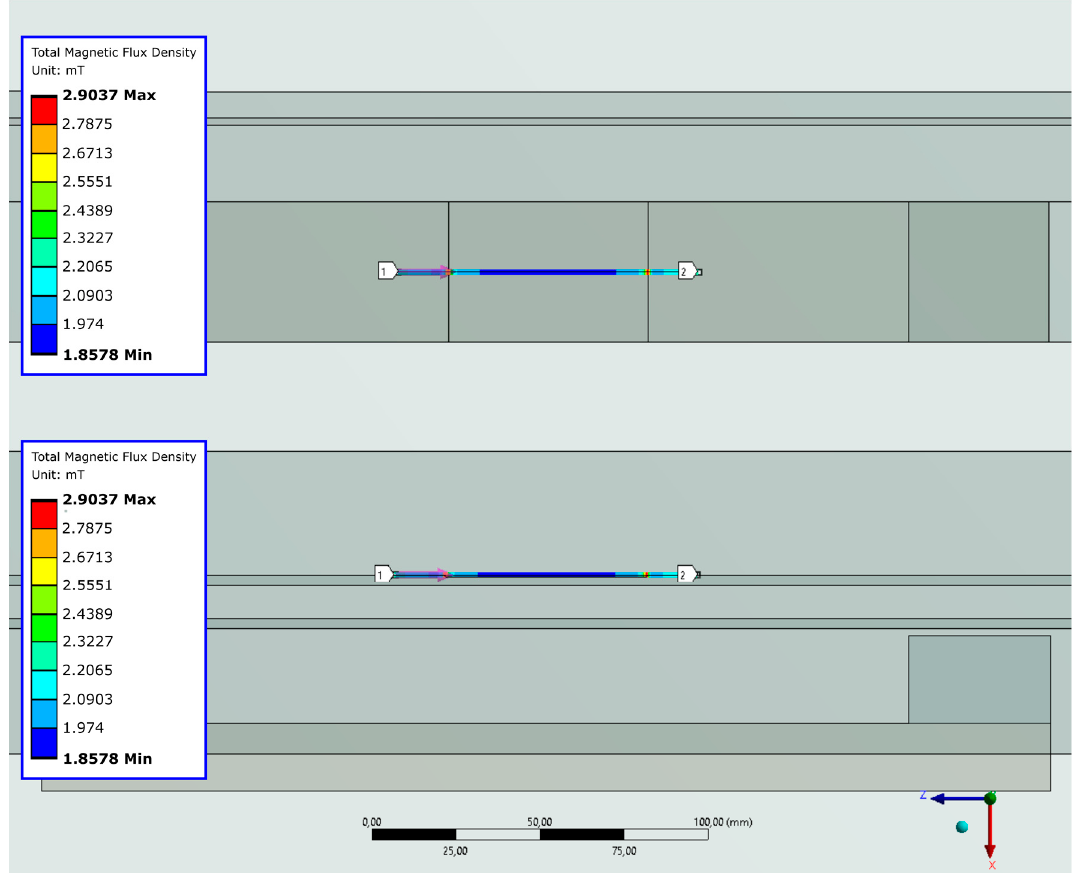
Figure 12. Form of detection line (called “path”).